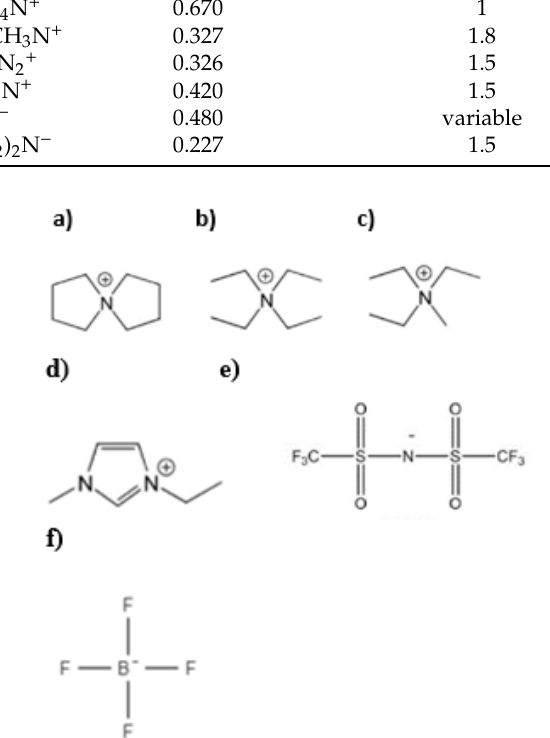
Figure 4. Chemical structures of cations and anions: ( a ) SBP, ( b ) TEA, ( c ) TEMA, ( d ) EMIm, ( e ) TFSI, ( f ) BF 4 [40,41].